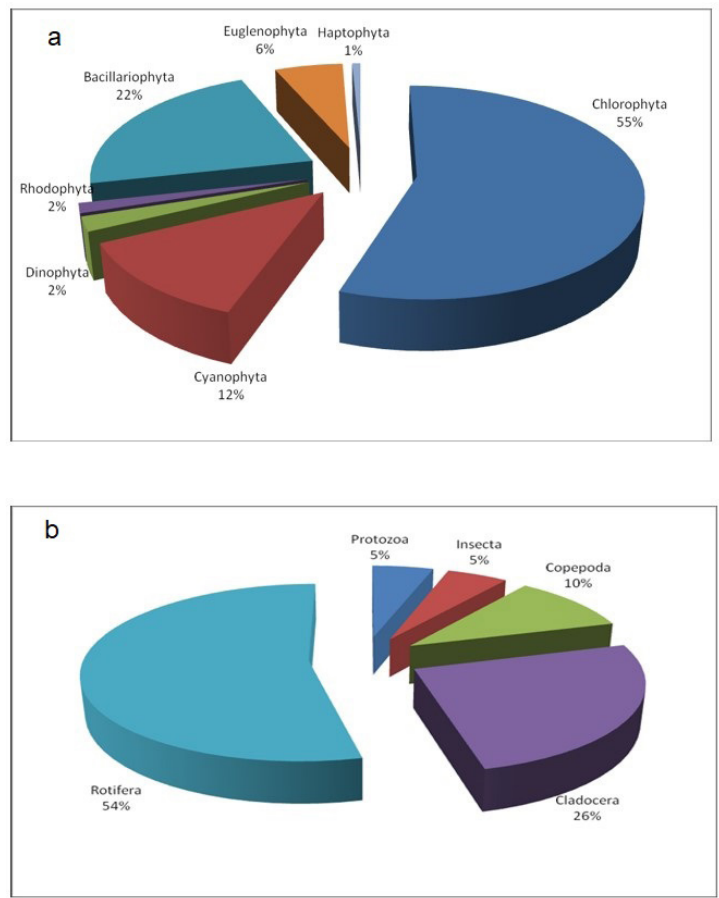
Figure 2. Taxonomic Composition of recorded phytoplankton (a) and zooplankton taxa (b) (based on recorded